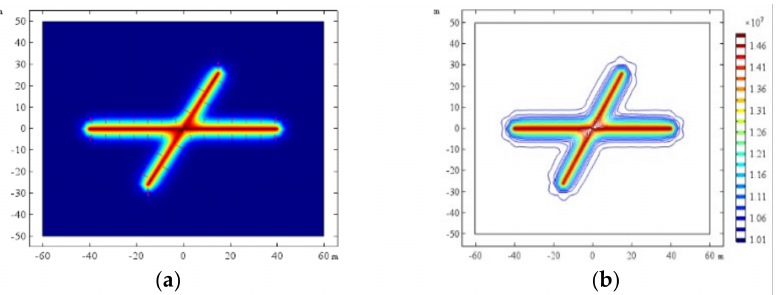
Figure 10. Case 7 calculation result. ( a ) Grout propagation pattern. ( b ) Distribution of grout propagation pressure field.